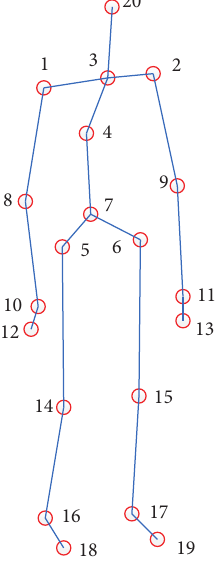
Figure 4: Skeleton of MSR Action